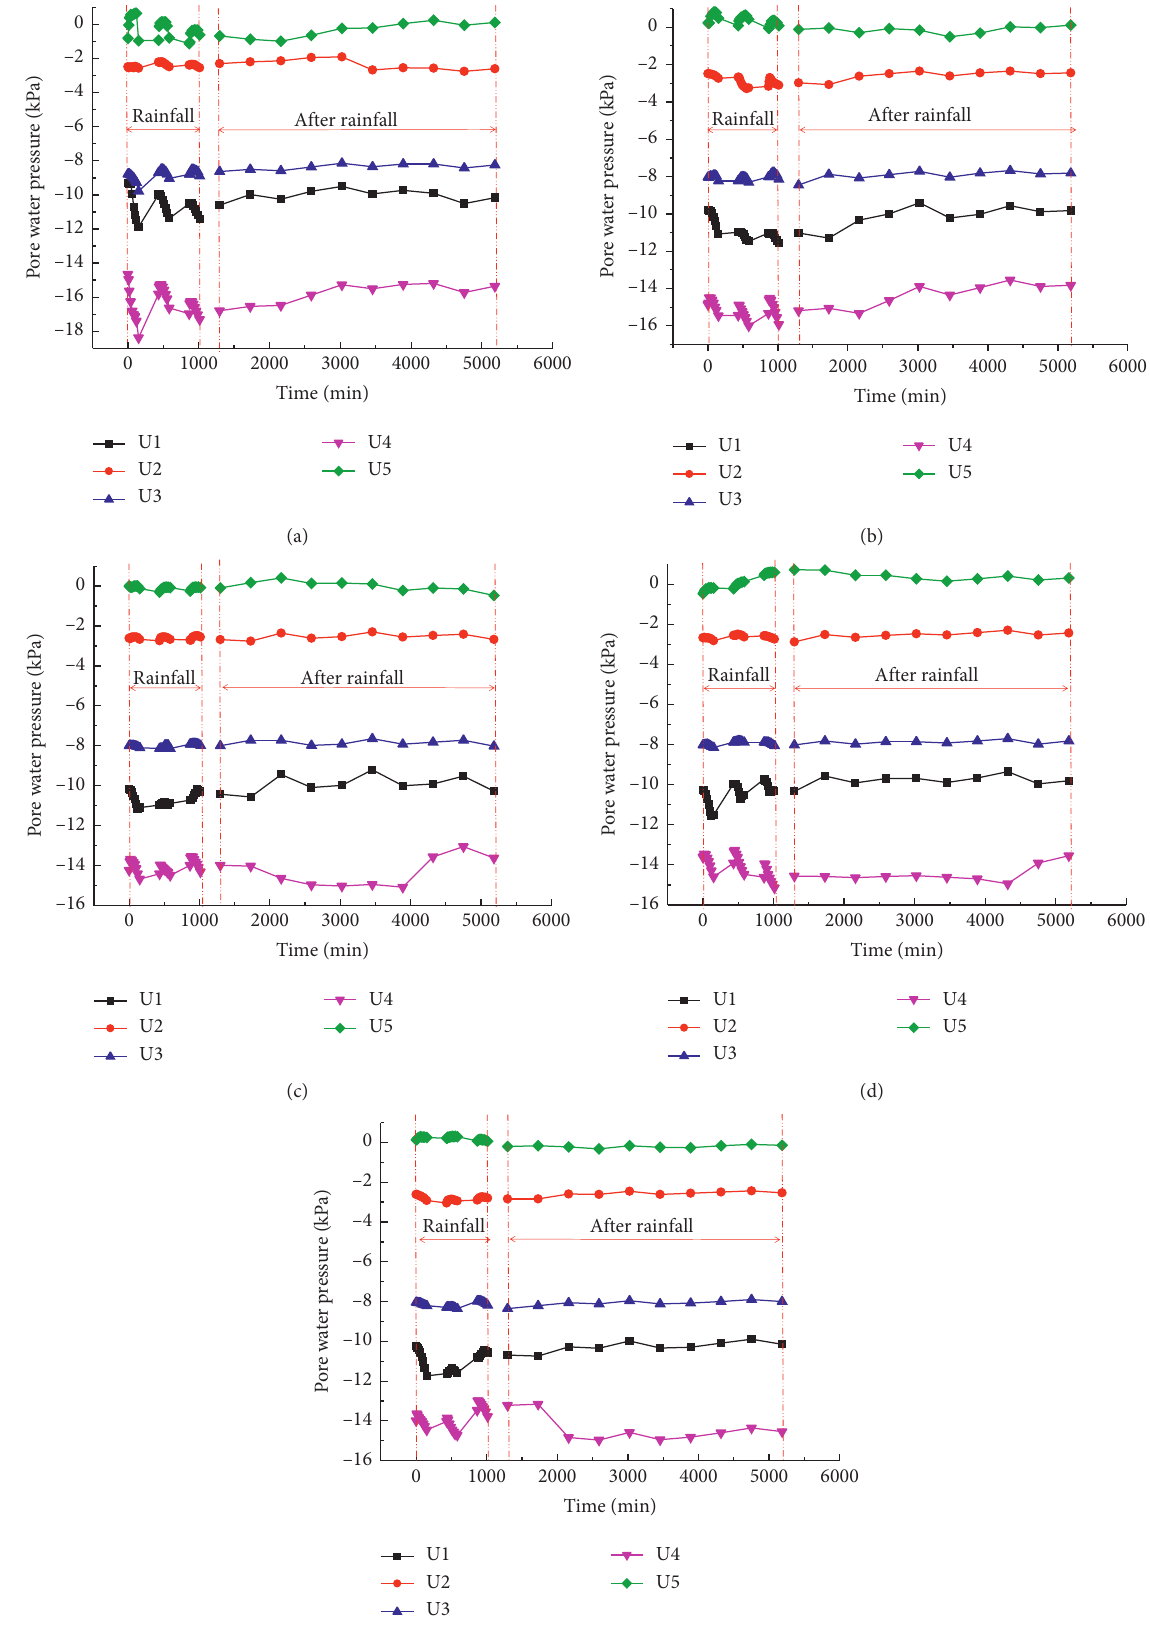
Figure 11: Pore water pressure variations within the test. (a) First year. (b) Second year. (c) Third year. (d) Fourth year. (e) Fifth